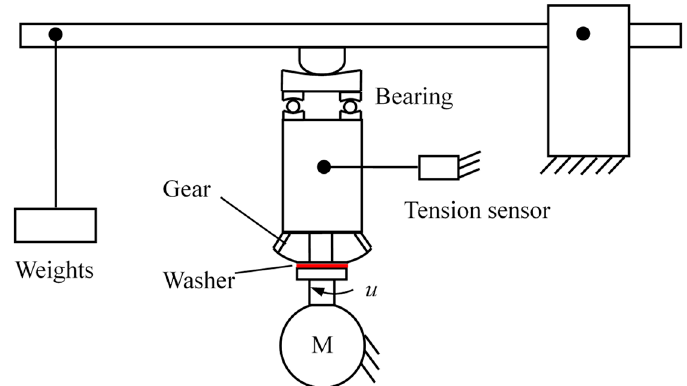
Figure 10. Schematic of the washer test rig.